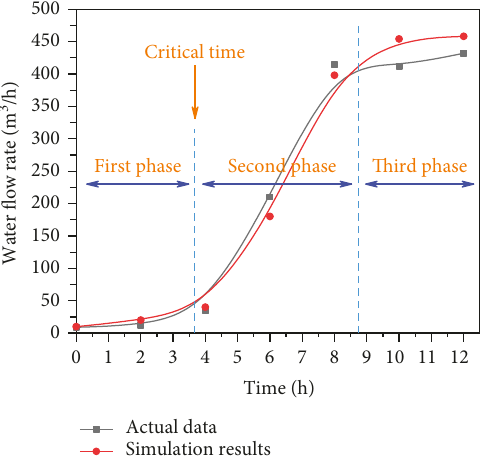
Figure 12: The comparison of water in fl ow between simulation results and actual